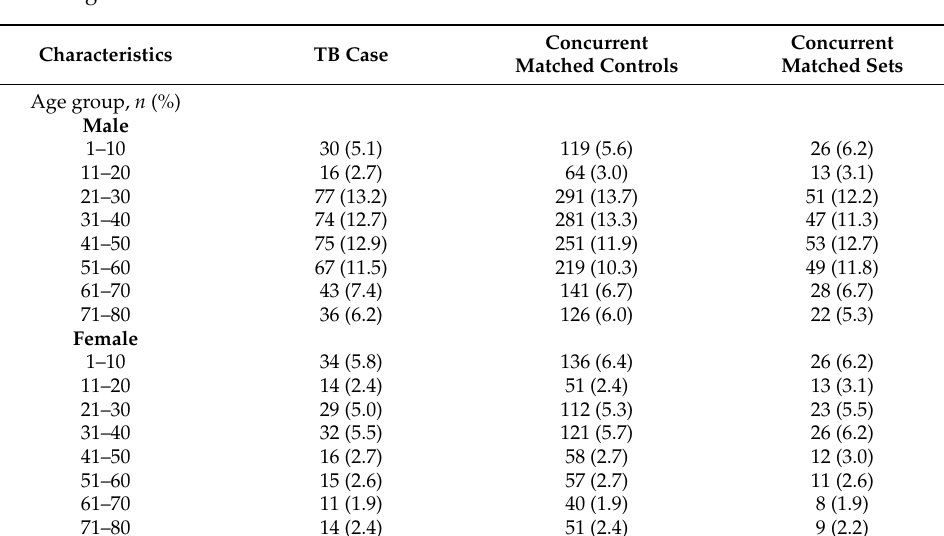
Figure 2. Study flow chart. AFB, acid-fast bacilli; DM, diabetes mellitus; HIV, human immunodeficiency virus; NHSO, National Health Security Office; OPD, outpatient department; TB, tuberculosis. Table 2. Age and sex distribution of the matched